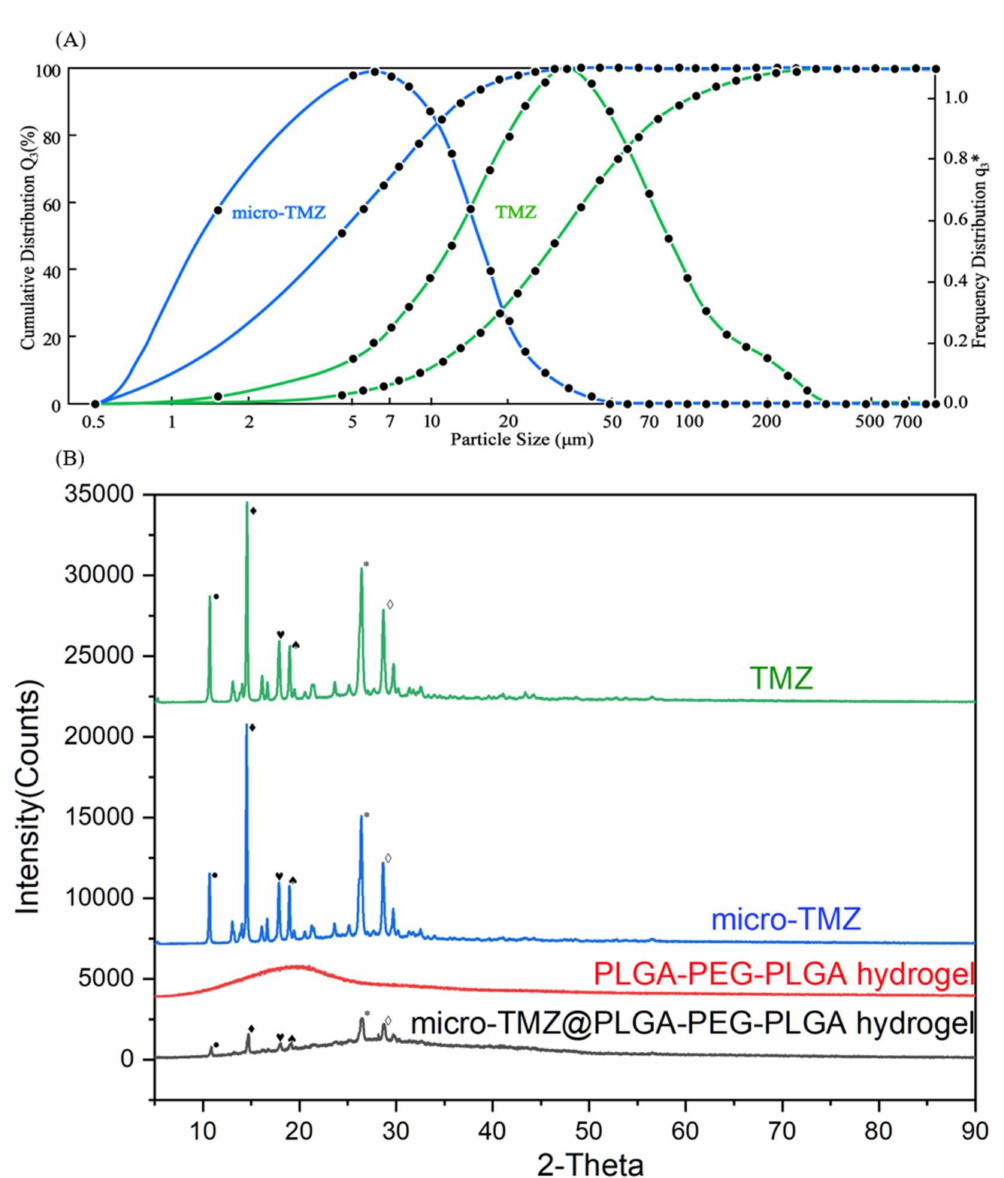
Figure 6. The crystal structure of TMZ and micro-TMZ. ( A ) Measurement of the dry particle size of TMZ and micro-TMZ. ( B ) XRD data for TMZ, micro-TMZ, PLGA–PEG–PLGA hydrogel (blank) and micro-TMZ@PLGA–PEG–PLGA hydrogel (100 mg/mL), the symbols are the unique diffraction angles in each